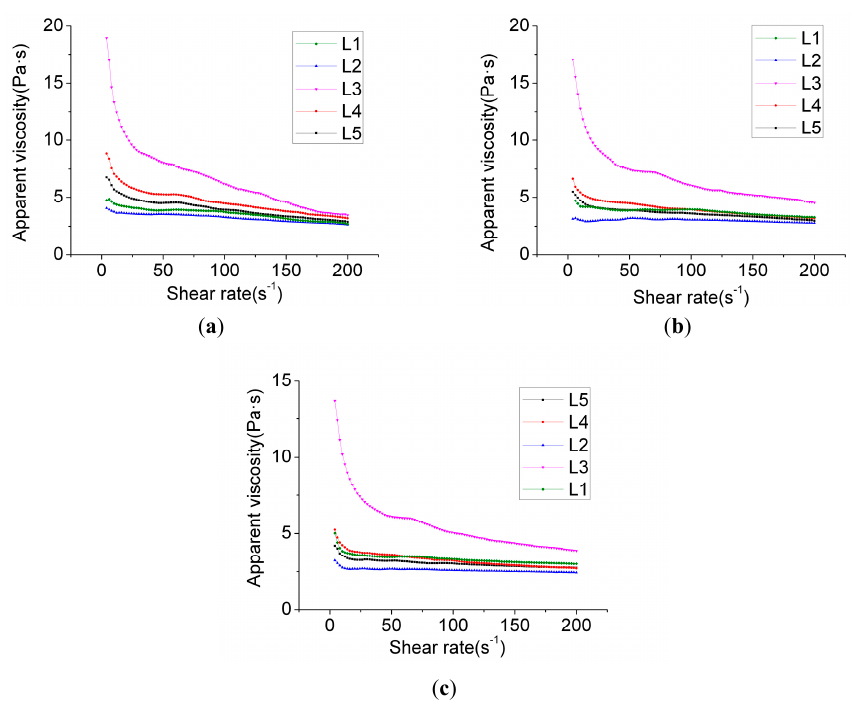
Figure 3. Apparent viscosity changes over time and changes with the shear rate. ( a ) Accelerated shear test (hydration for 1 min); ( b ) Accelerated shear test (hydration for 31 min); ( c ) Accelerated shear test (hydration for 121 min).